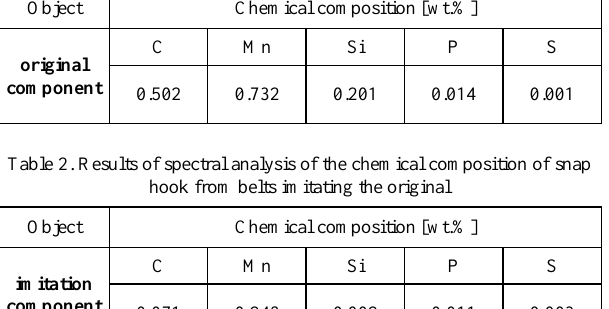
Table 1. Results of spectral analysis of the chemical composition of snap hook from original belts Object